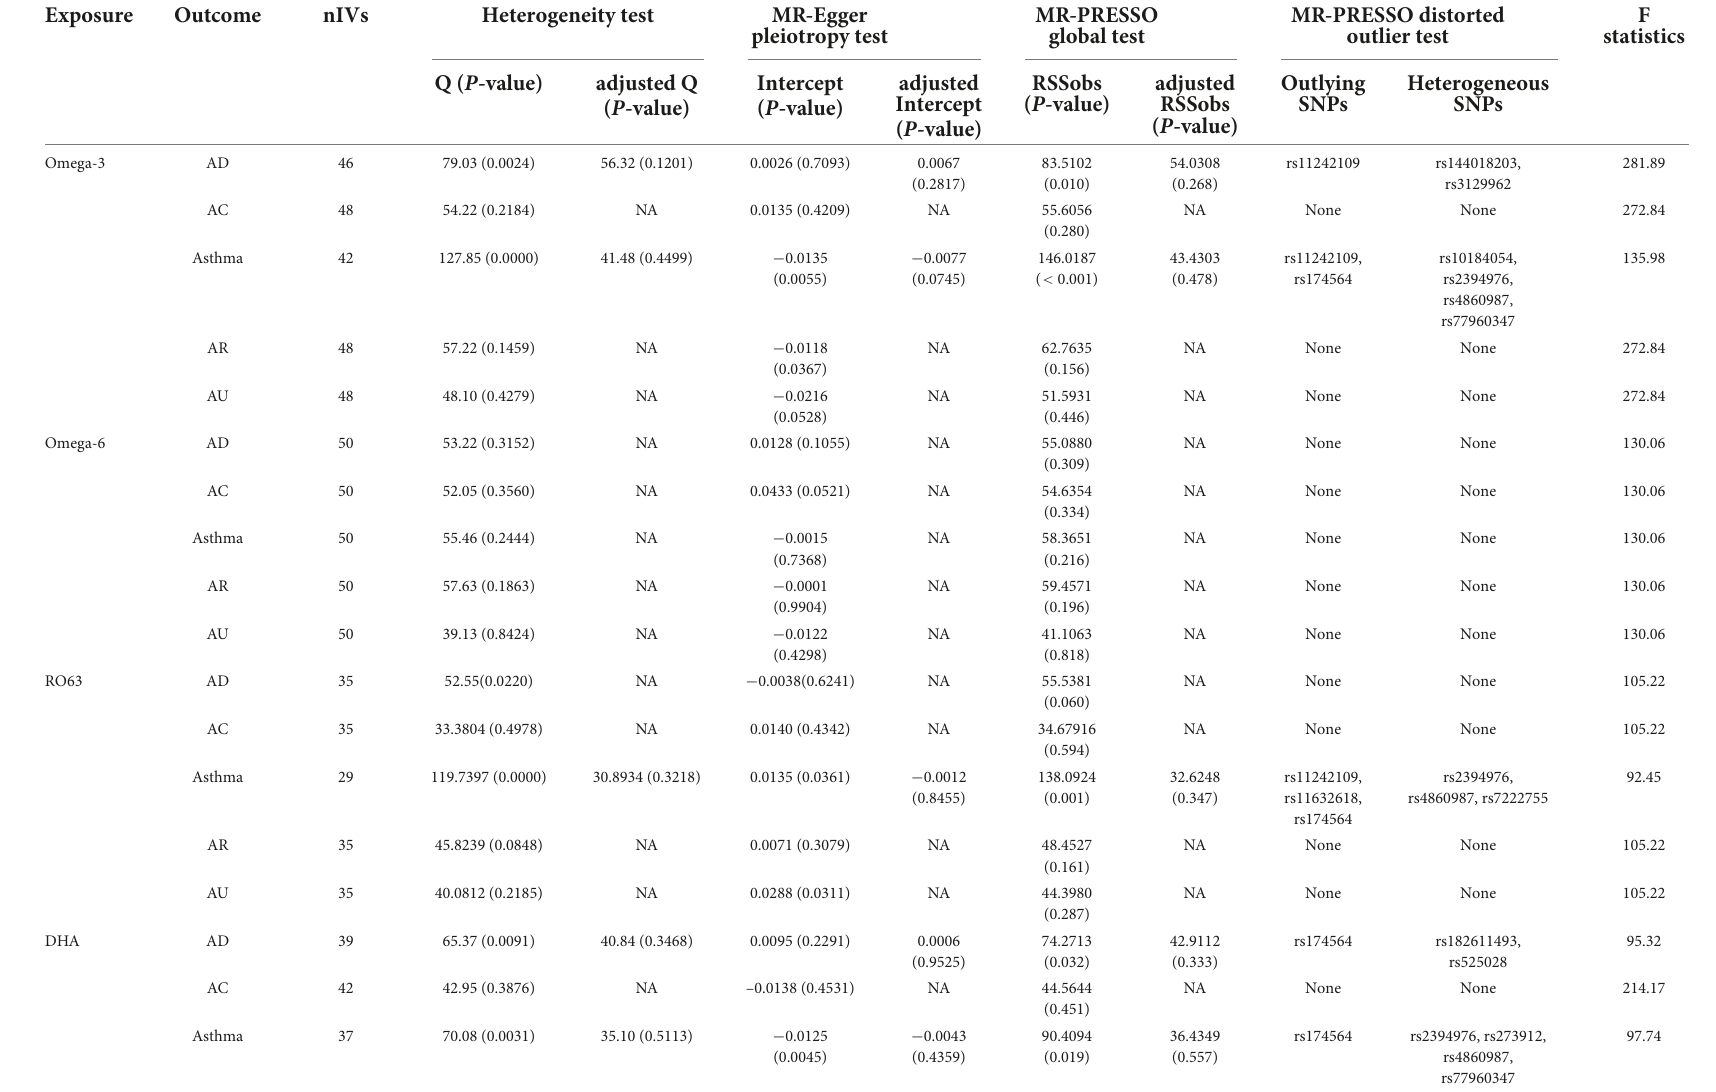
TABLE 1 Sensitivity analyses of the raw MR analysis and the adjusted MR analysis (adjusted by excluding all outliers and heterogeneous SNPs identified by the MR-PRESSO